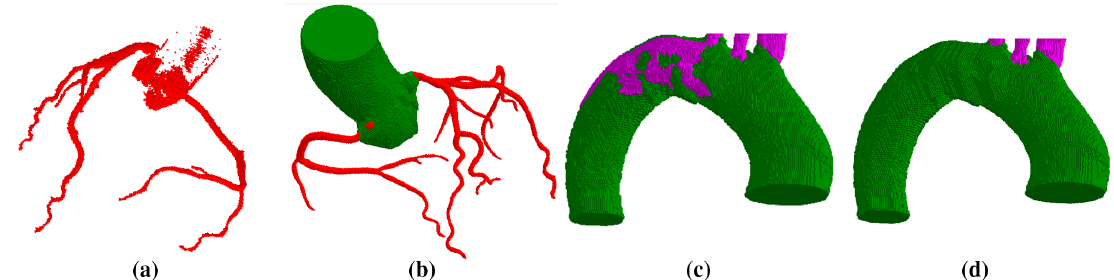
Figure 7. Segmentation errors near aorta border: ( a ) coronary arteries may be either connected or disconnected with segmentation “leaks”; ( b ) errors near ostia points show that false vesselness filter response may be both inside and outside of the aorta; ( c ) errors in the cerebral case and ( d ) result of our algorithm application. Green—aorta, red—mask of coronary vessels, purple—mask of cerebral